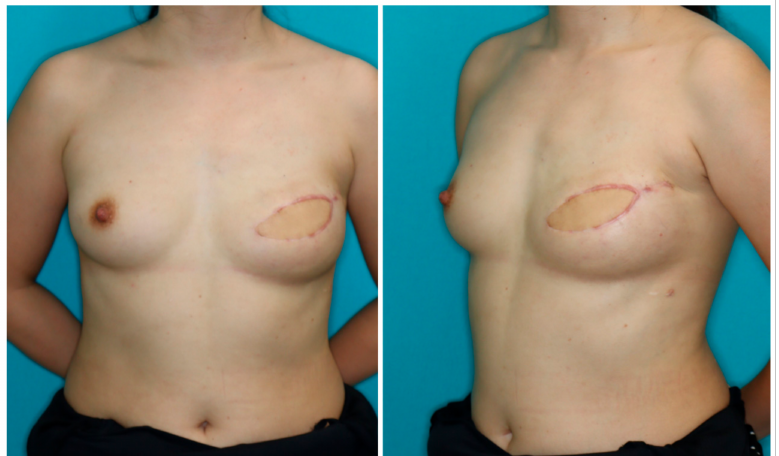
Figure 6. At the 12 months follow-up, the upper pole of the reconstructed breast retained its volume, and the patient was satisfied with the reconstructed